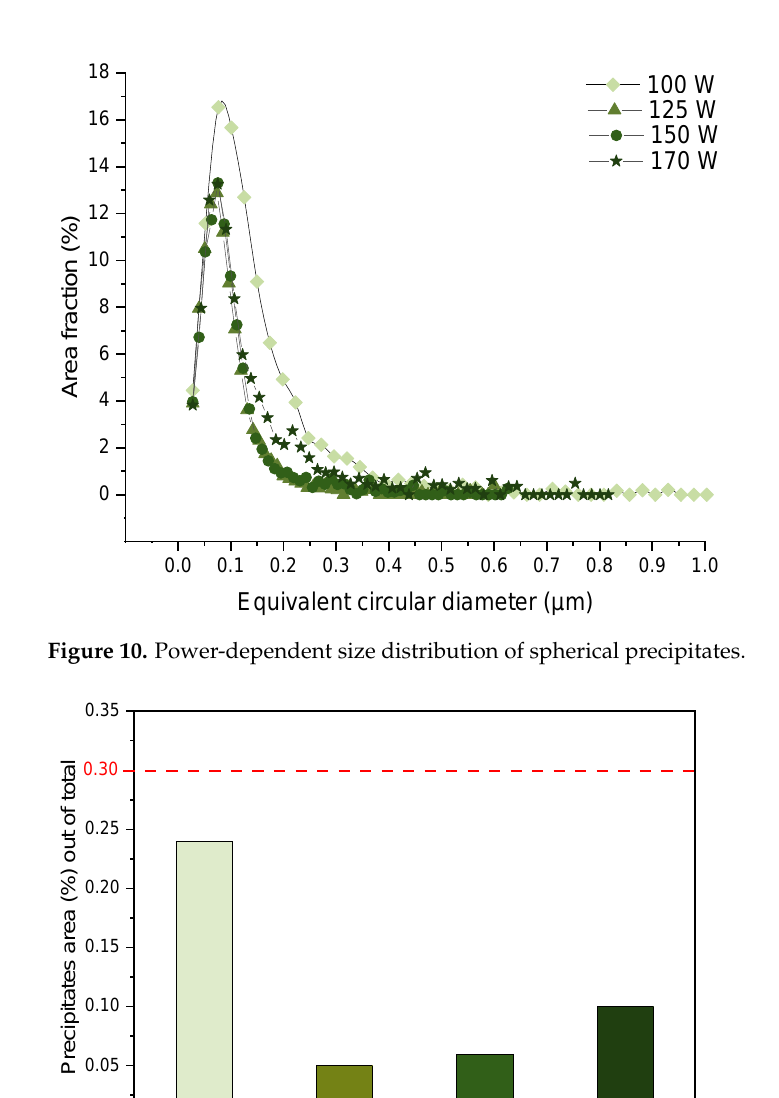
Figure 9. Precipitates aspect ratio distribution and Aztec images for each power condition.